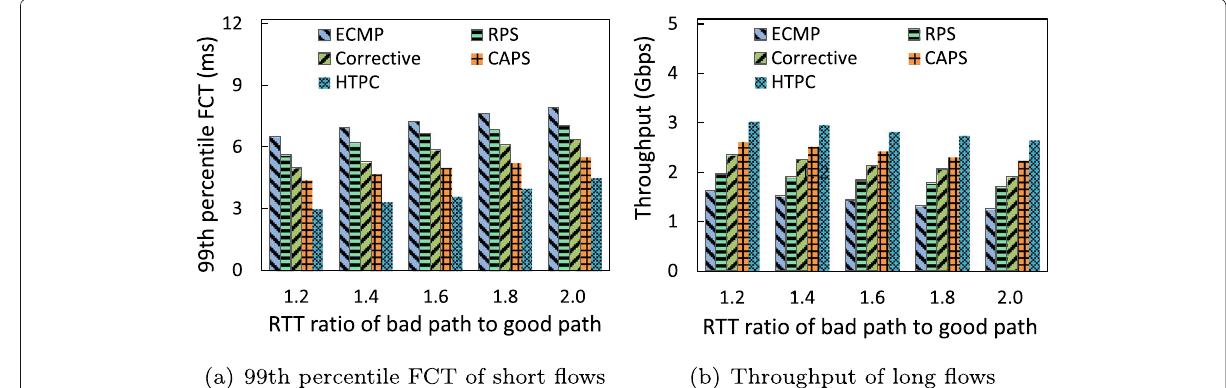
Fig. 12 Performance under asymmetric